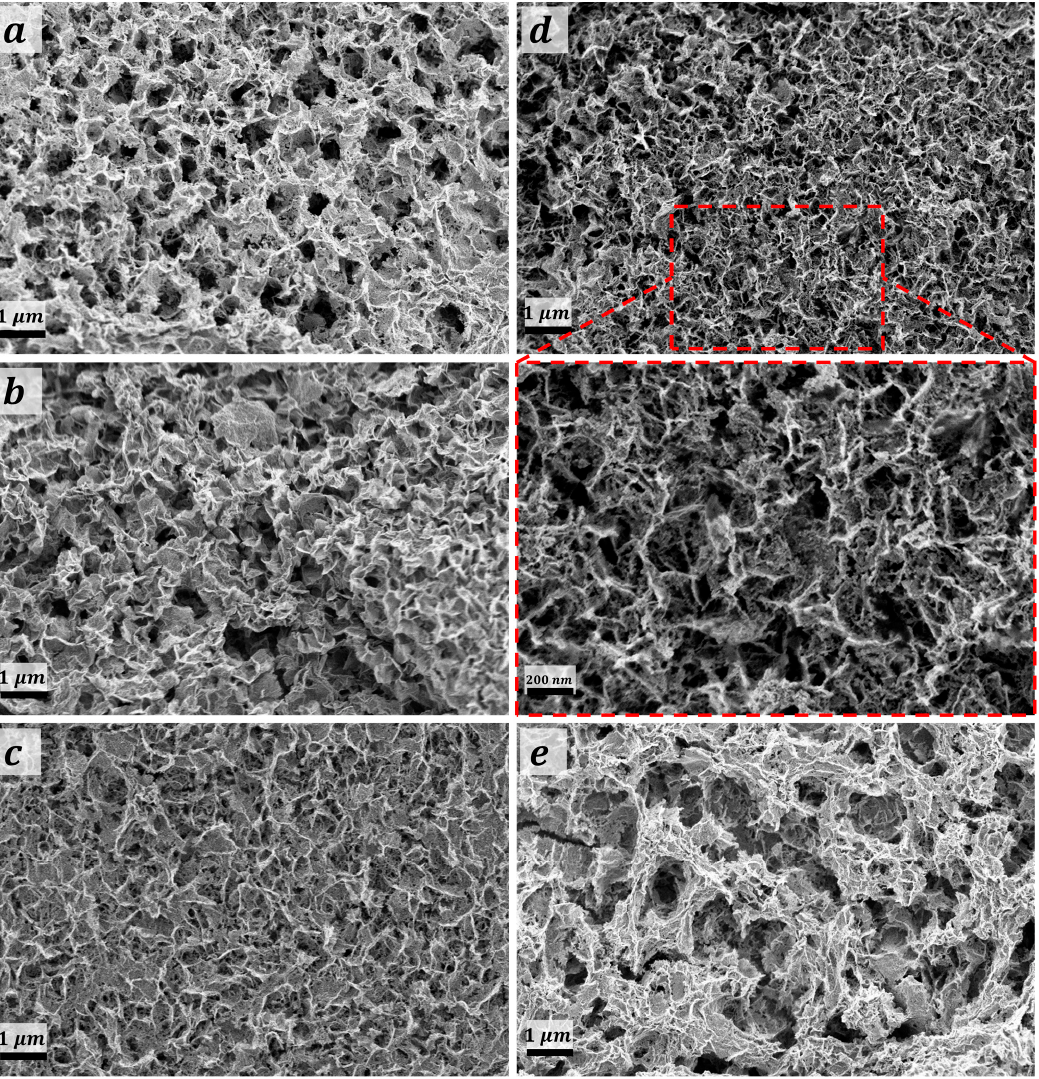
Figure 3. FE-SEM topographies of ( a ) MMO-550°, and CuO@MMO-T treated at ( b ) 350°, ( c ) 450°, ( d ) 550°, and ( e ) 650°. Figure 4a demonstrates the absorbance outcomes of CuO@MMO-550 together with CuO@MMO-550 containing N719 as a sensitizer. A cut-off absorption wavelength is cen-